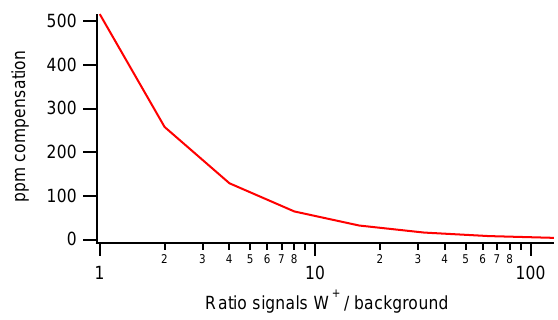
Figure 4. Estimated relative compensation that would need to be applied to the W + exact mass owing to an influencing, overlap- ping, background peak separated by 0.095Th and of relative signal strength indicated by the x